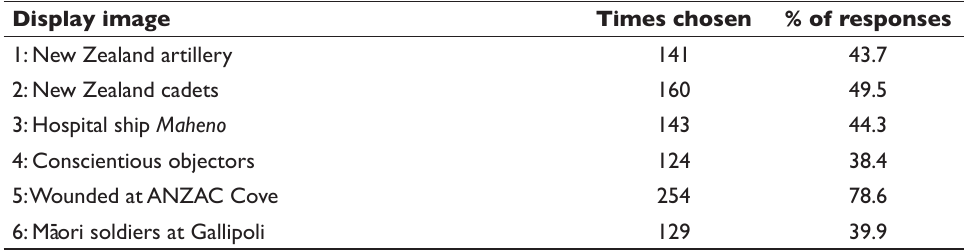
Table 3: Aggregateofallthreeofrespondents’choices Display